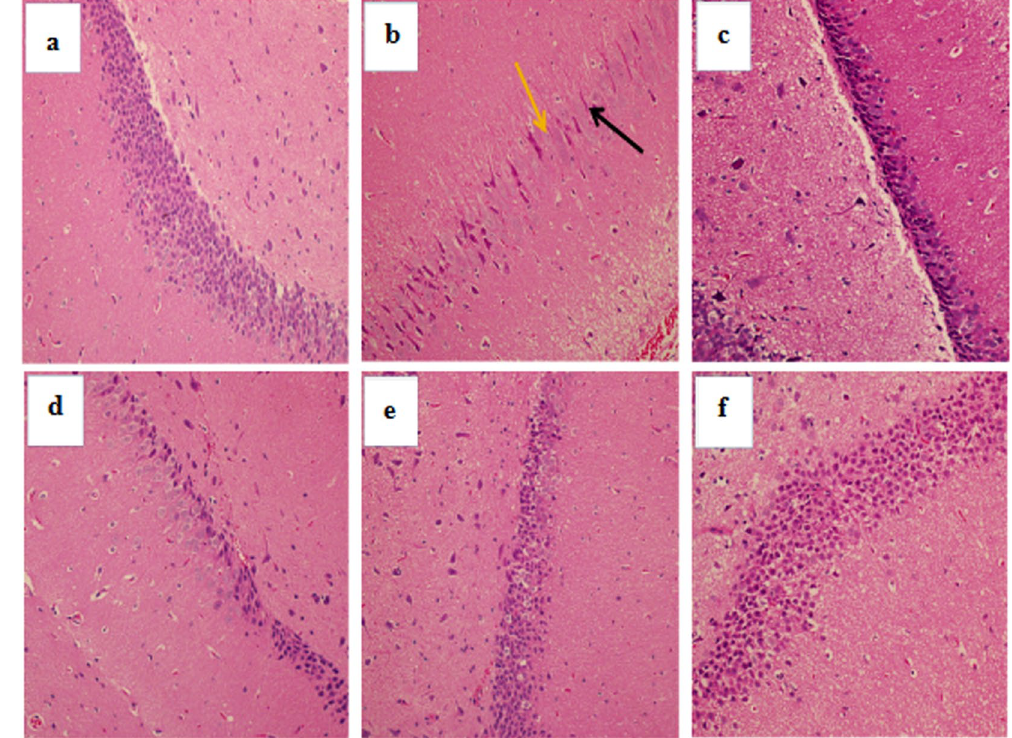
Figure 6. Effect of EA treatment on CA1 region of the hippocampus (H&E staining, magnification 200 × ). ( a ) Blank control group; ( b ) D-gal model group; ( c ) D-gal + VE150 mg/kg; ( d ) D-gal + EA50 mg/kg; ( e ) D-gal + EA100 mg/kg; ( f ) D-gal + EA150 mg/kg. Orange arrow indicated apoptosis and necrosis; Black arrow indicated irregular neurons.